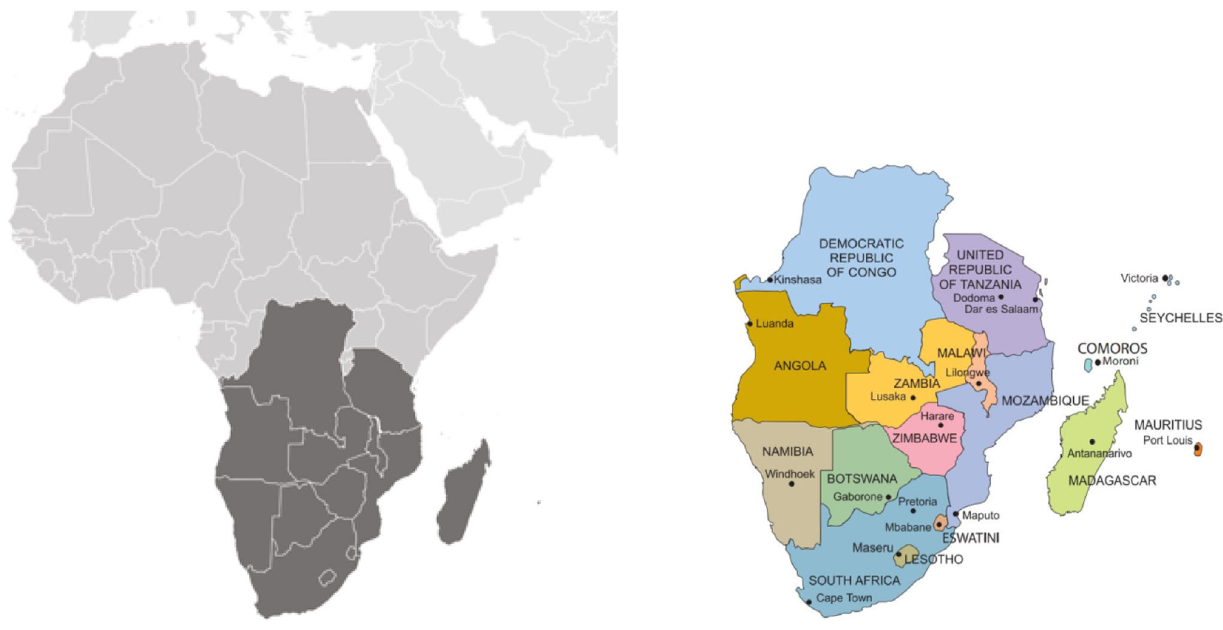
Fig. 1 Map of the Southern African Development Community (SADC) Region. Sources Authors and SADC (https://www.sadc.int/about-sadc/